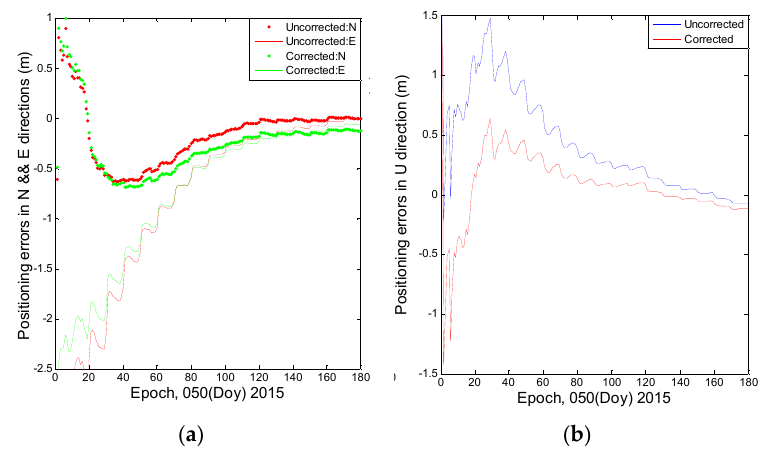
Figure 20. The positioning errors during the first 180 epochs at station CUT0based on the corrected and raw observations. ( a ) Describes the positioning errors in N and E directions; ( b ) Describes the positioning errors in U direction.